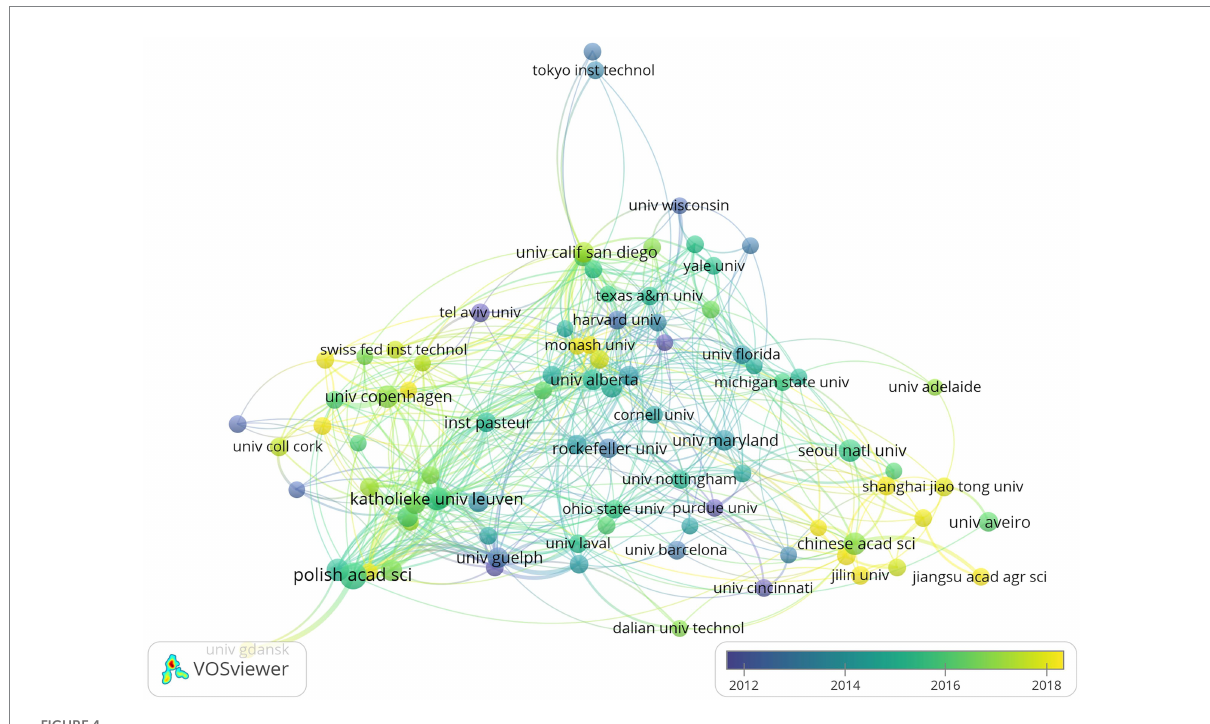
FIGURE 4 A visual map of institutional collaboration